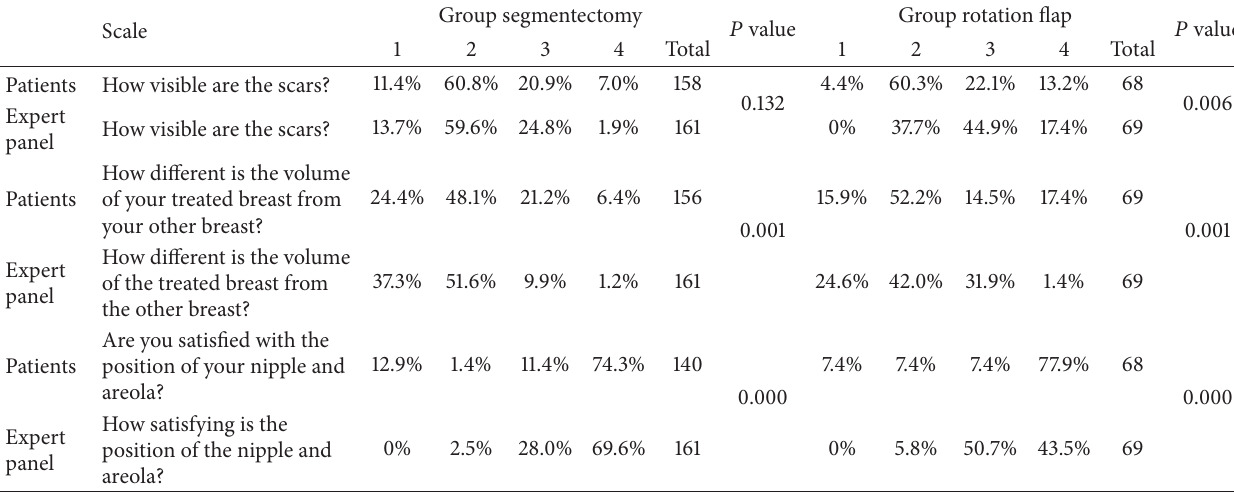
Table 4: Comparison of the expert panel and patient answers to the